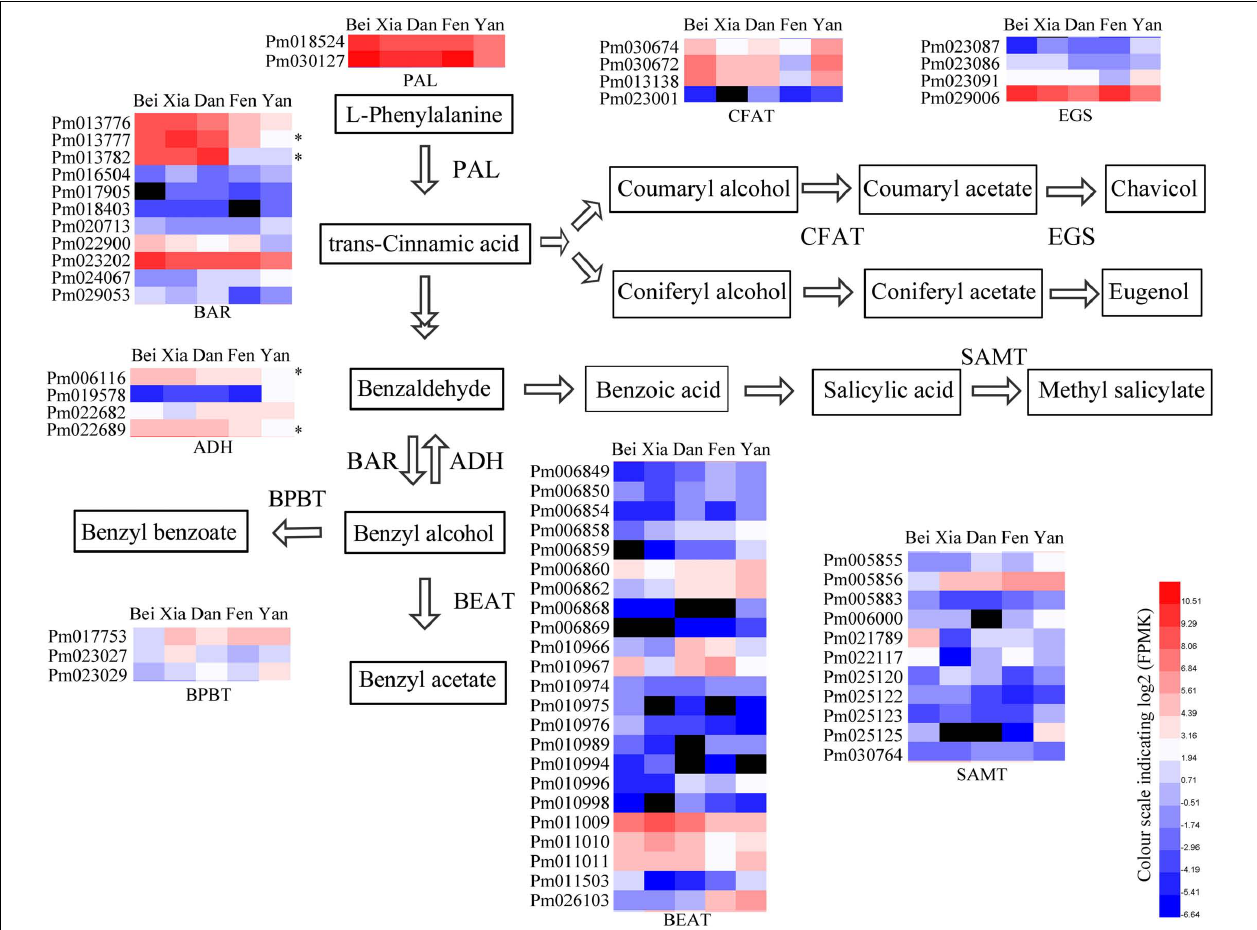
FIGURE 5 | Heat maps of the differential expressed genes encoding key enzymes in the floral scent biosynthetic pathway in the five varieties. The key floral scent biosynthetic pathway in P. mume is shown. In the heat maps, red and blue represent high and low transcript expression, respectively, and black represents undetectable expression. The asterisks indicate the genes with strong positive correlations between gene expression and enzyme